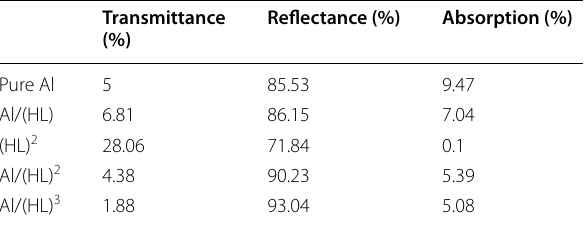
Table 2 Reflectance, transmittance, and absorption rates of